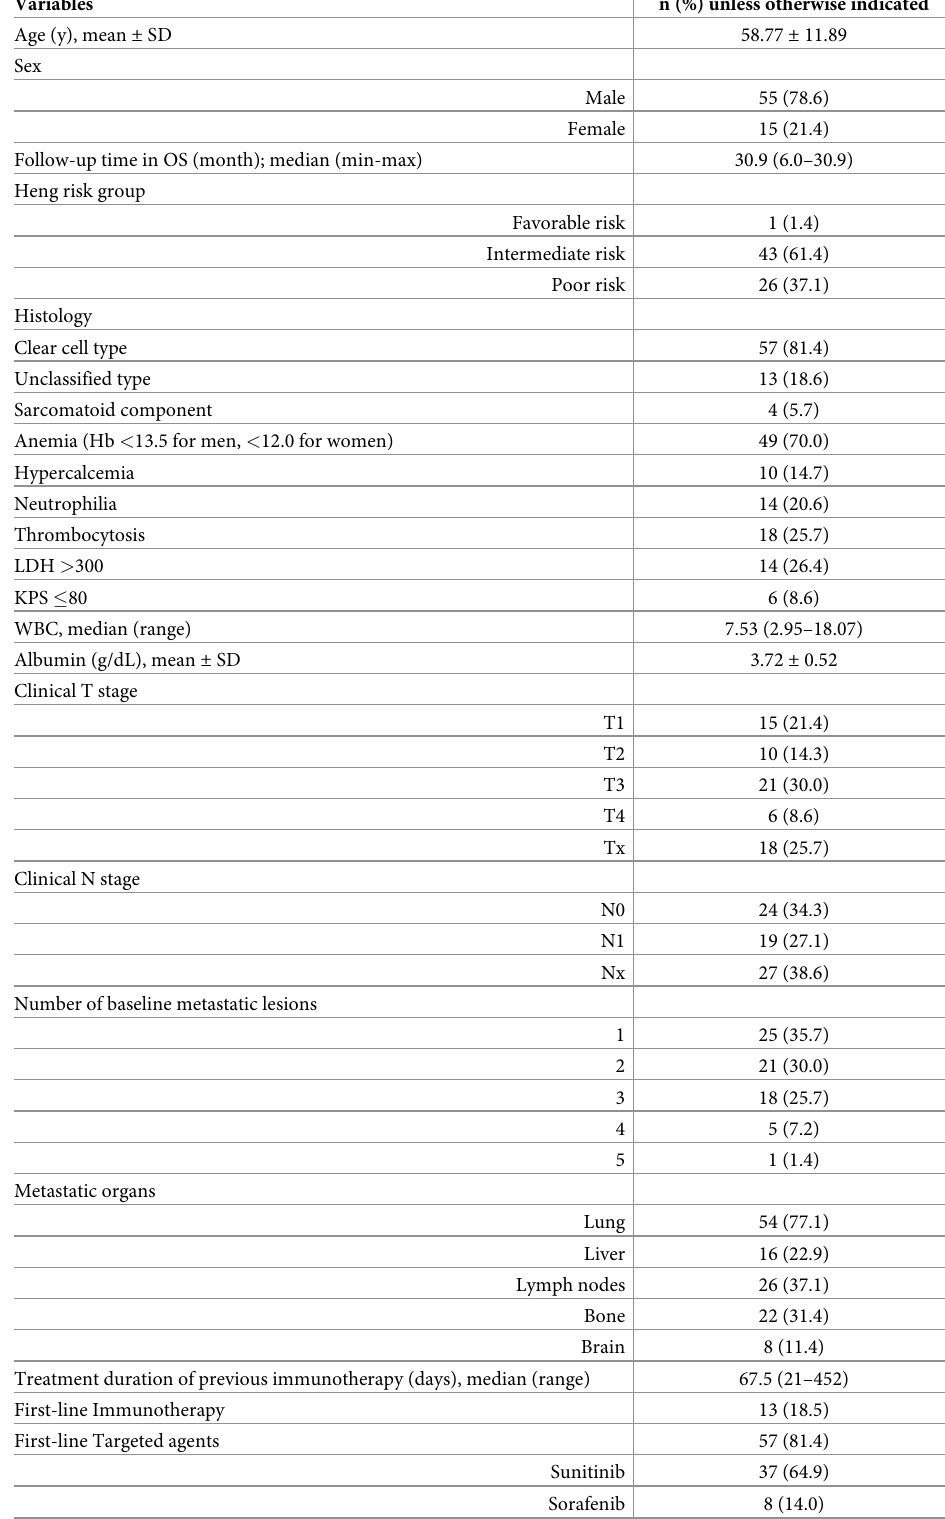
Table 1. Patient baseline demographics (N =